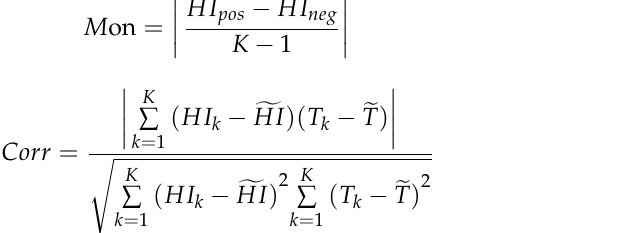
Figure 11. Data processing process.